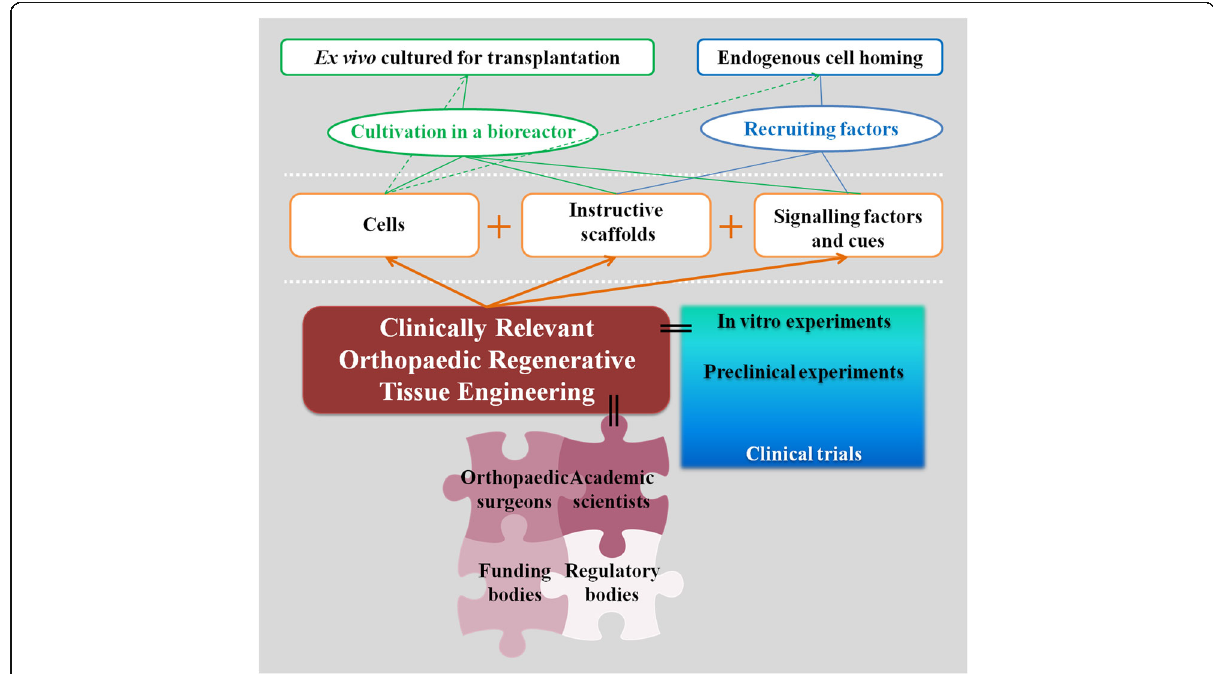
Fig. 1 Clinically relevant orthopaedic regenerative tissue engineering strategies. Cells, scaffolds, and signalling factors are the main components of regenerative tissue engineering. Ex vivo cultured cells can be transplanted with or without cultivation in a bioreactor or an in situ tissue regeneration strategy can be followed for endogenous cell homing with the recruited factors such as instructive scaffolds and/or signalling factors can be used. Strong evidence from in vitro and preclinical experiments are needed prior to initiating a clinical trial in humans. Strategies should be developed in a translational research environment with the involvement and communication all stakeholders since the